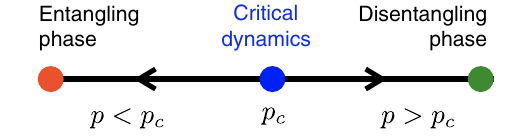
FIG. 1. Phase diagram as a function of p , the rate at which measurements are made for each degree of freedom. Arrows indicate renormalization-group